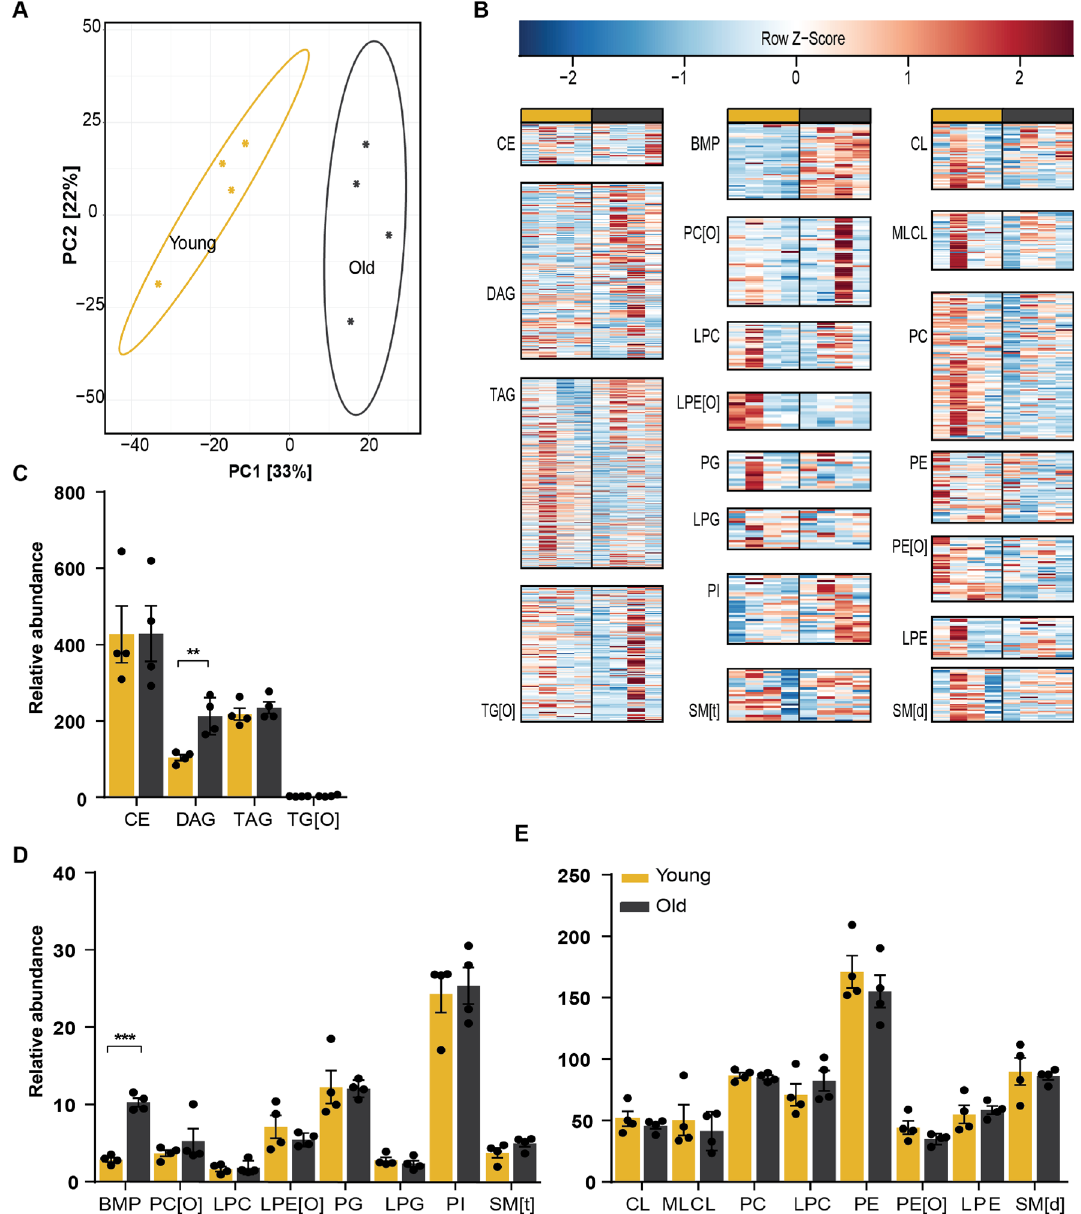
Figure 3. Aged BAT accumulates DAG and BMP. ( A ) Principal component analysis of young and aged mice BAT lipidome shows clear separation. ( B ) Heatmaps of all lipid classes arranged from left to right by lipid abundance and ordered from top to bottom by acyl chain length. Relative abundance of ( C ) sterol and glycerolipids; ( D ), ( E ) glycerophospholipids and sphingomyelins show accumulation of BMPs and DAGs. **P < 0.01, ***P < 0.001 (unpaired Student’s t-test) (n = 4). PCA analysis and heatmaps were created in R programming language (v3.6.3; http://www.r-proje ct.org). Bar graphs were created in Graphpad Prism (v8.3.0; https ://www.graph pad.com/scien tific -softw are/prism /). Figure layout was prepared in Adobe Illustrator CS6 (v16.0.3; https ://www.adobe